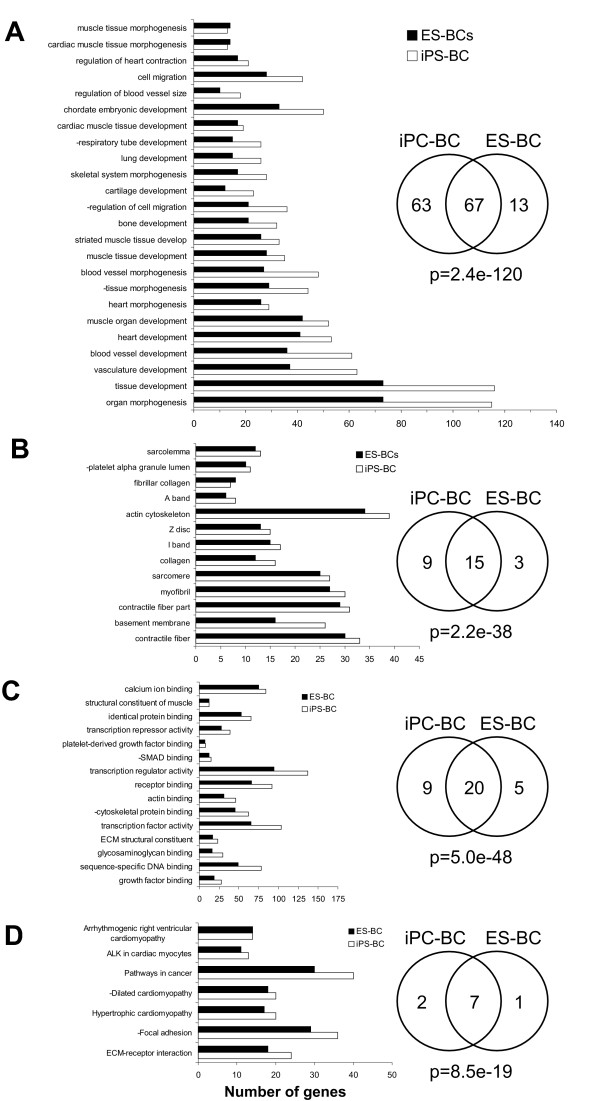
Gene ontology and KEGG pathway analysis of genes upregulated in beating clusters of ES and iPS cells. Processes and pathways found to be most overrepresented in microdissected human iPS-BCs and ES-BCs are presented for categories: biological processes (A), molecular function (B), cellular pathway (C) and KEGG pathways (D). Detailed lists of GOterms significantly enriched in iPS-BCs and ES-BCs and the corresponding statistical information are given in Table S20. The p-values under Venn diagrams have been calculated using the Fisher's exact test (we used 17593 as the total number of GO-terms in the GO-database in these calculations).